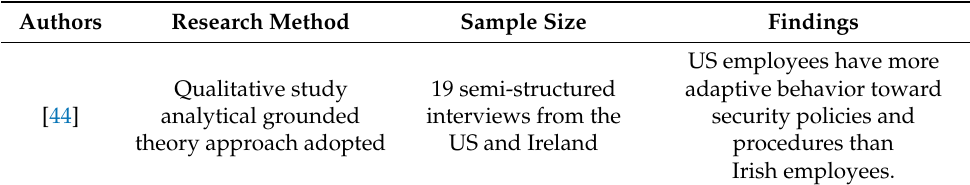
Table 4. Studies on national culture and ISPC.